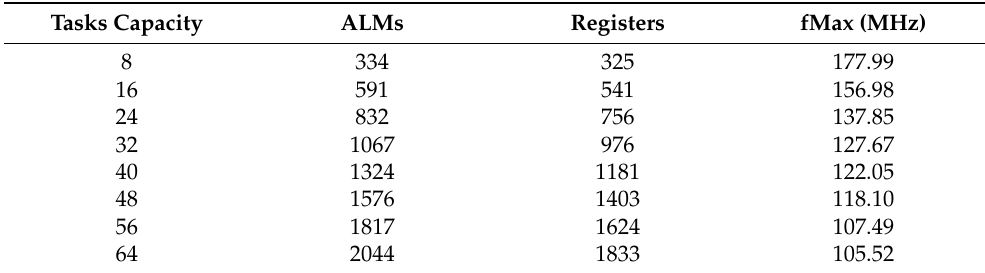
Table 3. FPGA synthesis